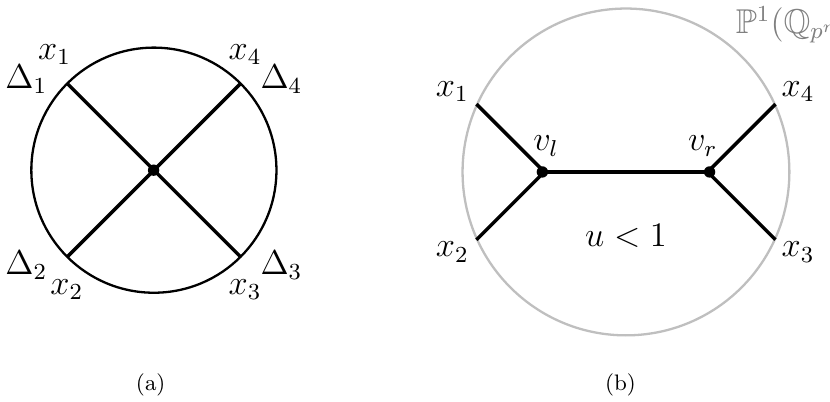
Figure 3 . (a) The bulk 4-point contact Feynman diagram for scalar (cid:12)elds with scaling dimensions (cid:1) i . (b) The coordinate con(cid:12)guration on the Bruhat-Tits tree. Solid lines are geodesics on the Bruhat-Tits tree, tracing the path joining together the four points on the boundary of the tree, which is the projective line over the degree n unrami(cid:12)ed extension of Q p . The (cid:12)gure is drawn for u < 1 where u; v are de(cid:12)ned in eq. (3.7). For the u = v = 1 con(cid:12)guration, the vertices on the Bruhat-Tits tree, labeled v l and v r , become